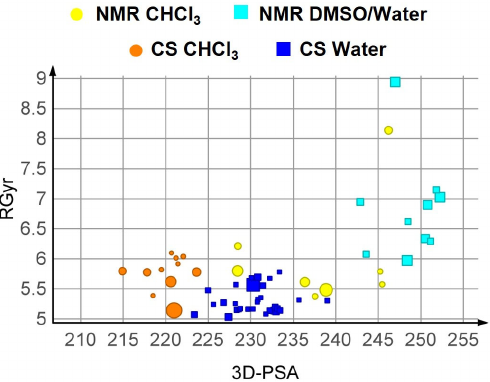
Figure 7. Comparison between NMR and MOPAC post ‐ minimization results (MO1), weighted plot.